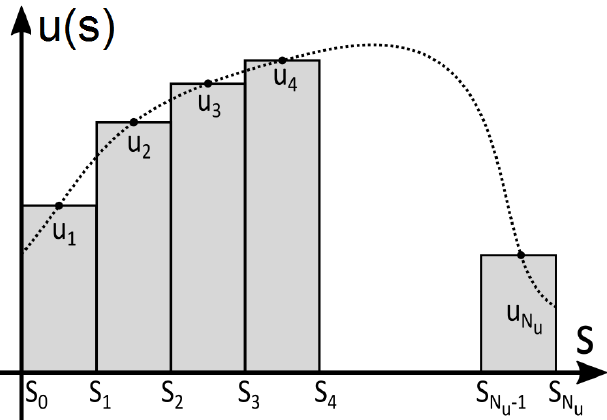
Figure 2. Staircase or polynomial approximation of the unknown boundary condition on the domain edge.